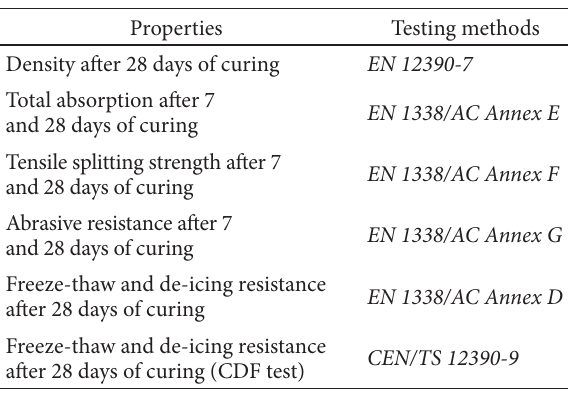
Table 3. Test methods of paving